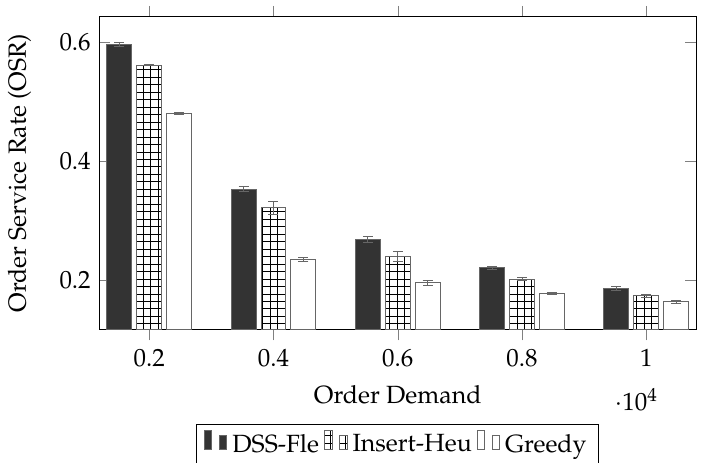
Figure 3. Order service rates of